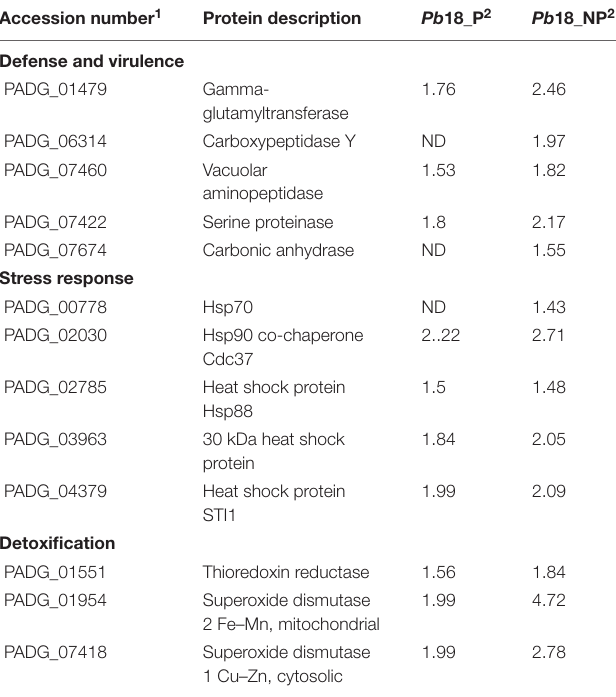
TABLE 1 | Up-regulated proteins putatively related to cell rescue, defense, and virulence in Pb 18_A and Pb